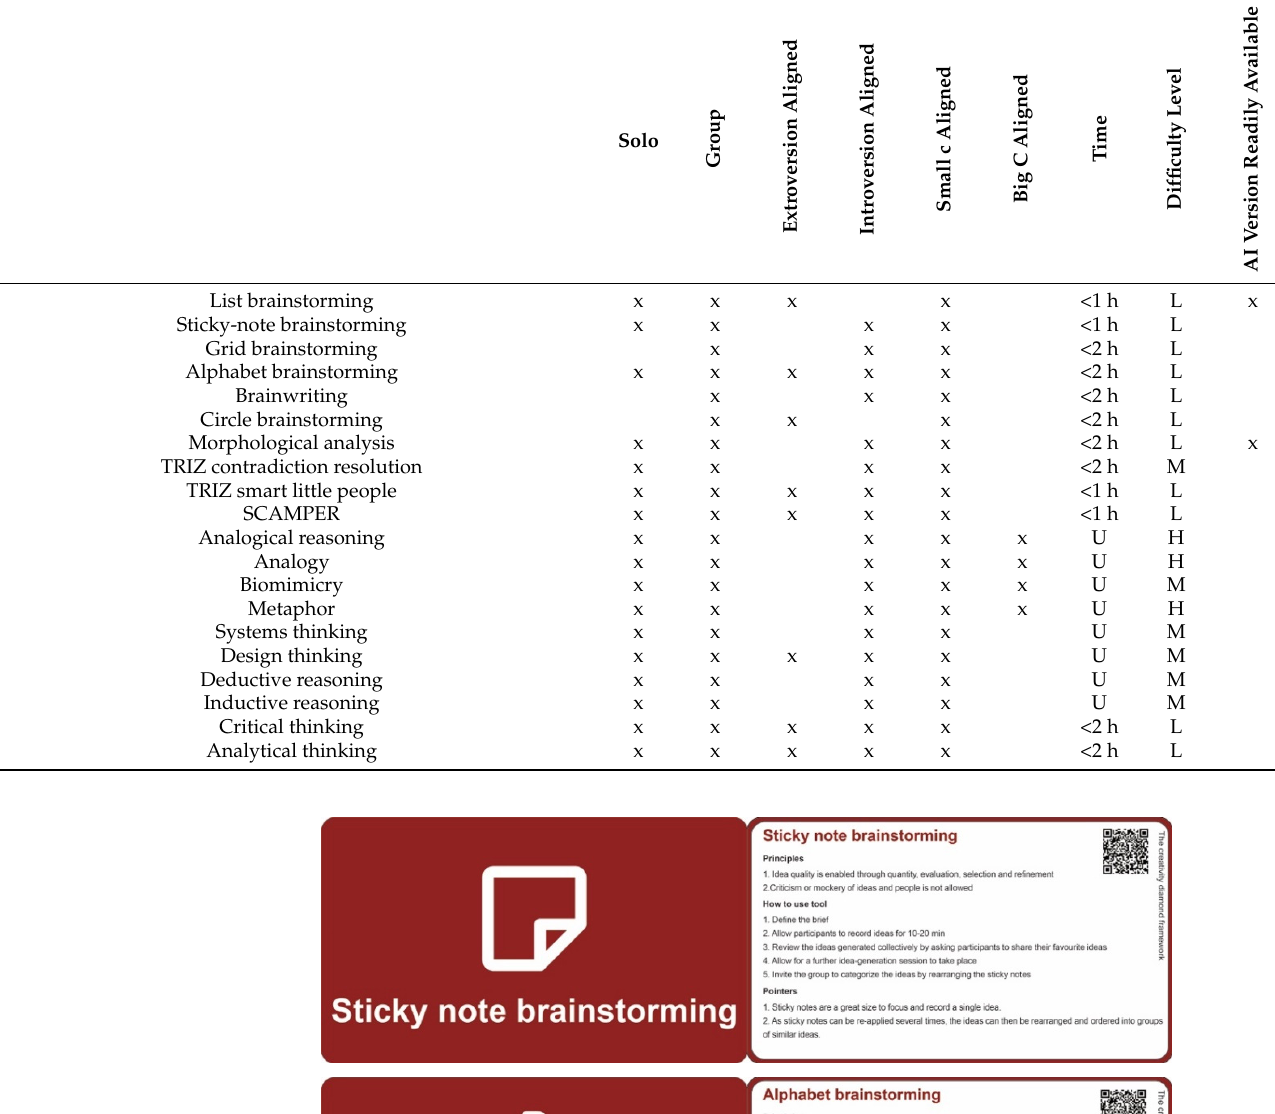
Table 2. Creativity approach attributes. X = indicative; times are approximate; levels are indicative;